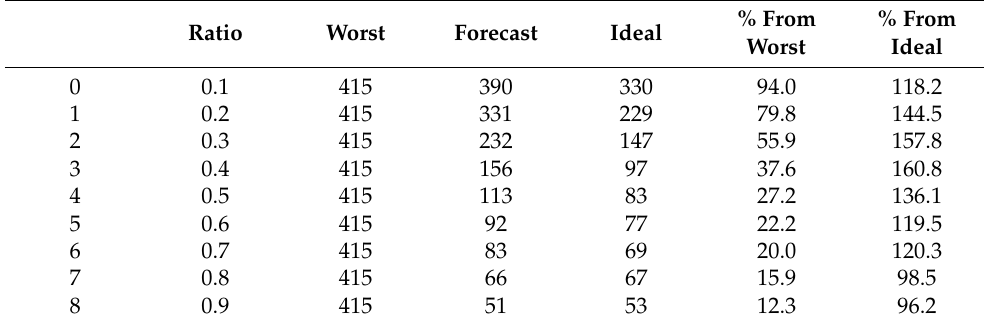
Table 7. Cumulative sums at various ratio